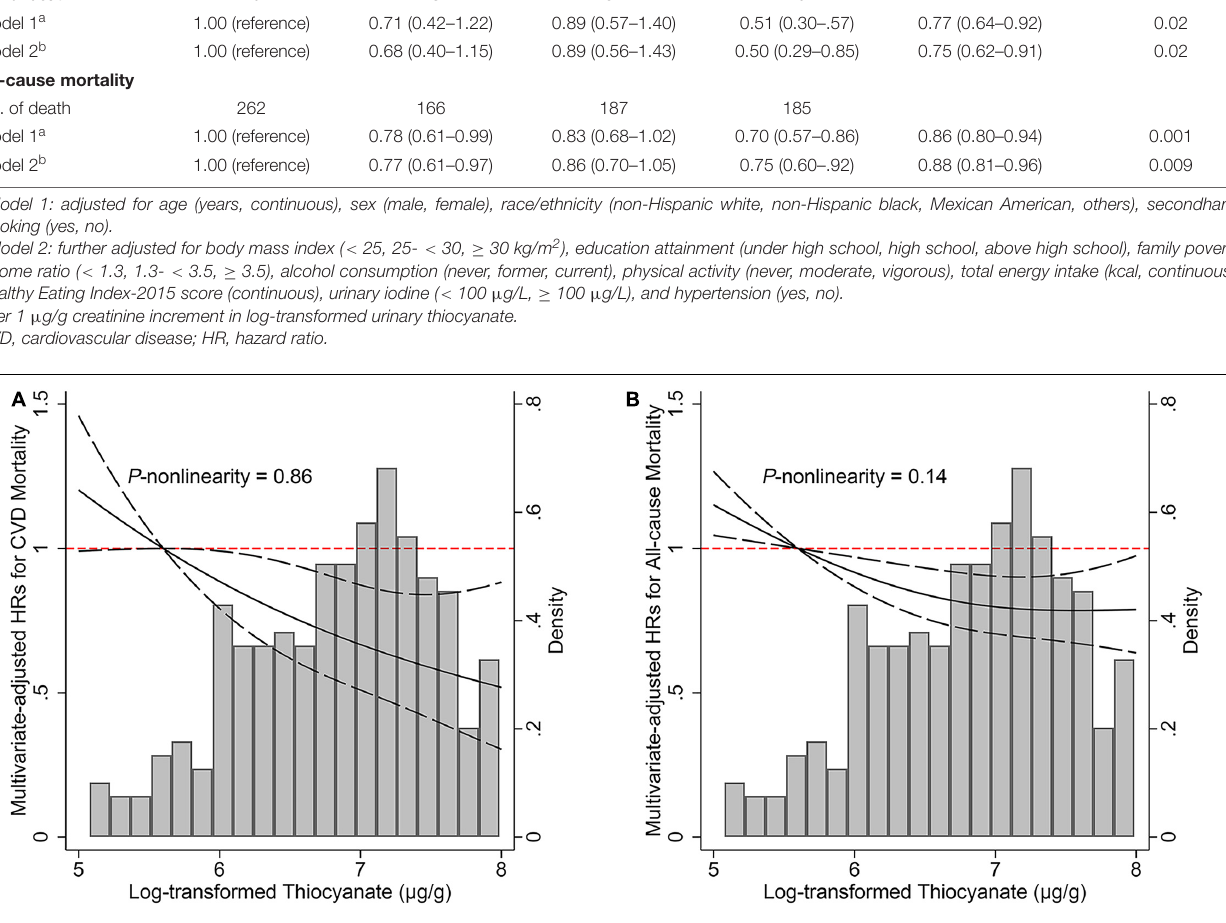
multivariate-adjusted HRs for CVD and all-cause mortality were 0.50 (95% CI: 0.29–0.85) and 0.75 (95% CI: 0.60–0.92), respectively. Moreover, each 1 µ g/g creatinine increment urinary